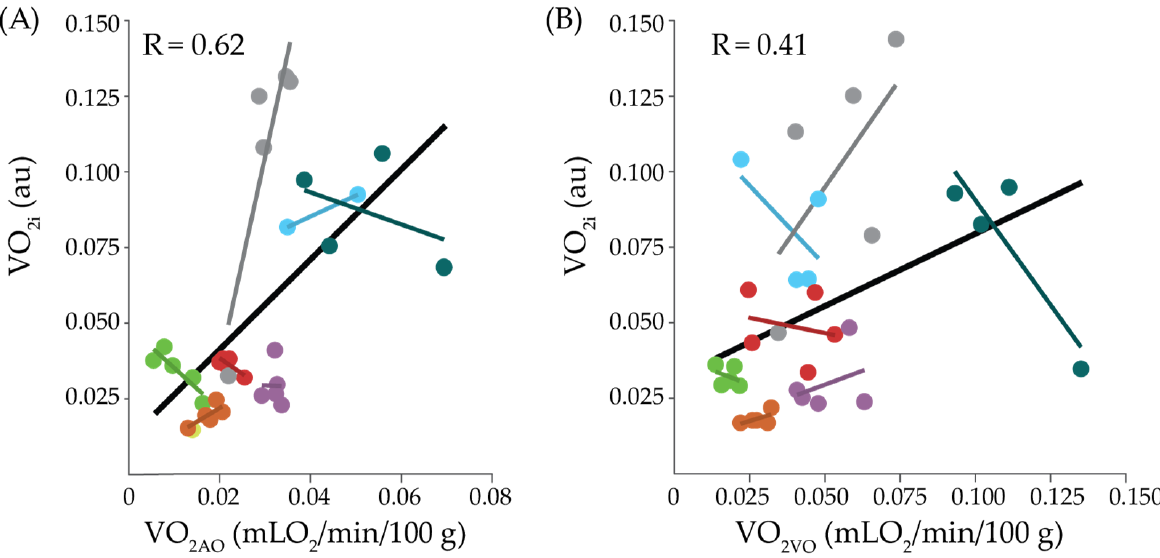
Figure 3. Comparison of oxygen metabolism measured with NIRS versus NIRS + DCS. ( A ) Oxygen metabolism measured with NIRS during arterial occlusion (VO 2AO ) at 3.5 cm versus NIRS + DCS-measured oxygen metabolism index (VO 2i ) averaged 15 s prior to arterial occlusion. ( B ) Oxygen metabolism measured with NIRS during venous occlusion (VO 2VO ) versus NIRS + DCS-measured oxygen metabolism index (VO 2i ), averaged 15 s prior to venous occlusion; VO 2i is in units of cm 2 /s*mLO 2 /g × 10 -6 . The solid black line and indicates the overall linear fit for the group data. Colored lines indicate linear fit for individual participants. In both figures, data are color-coded by